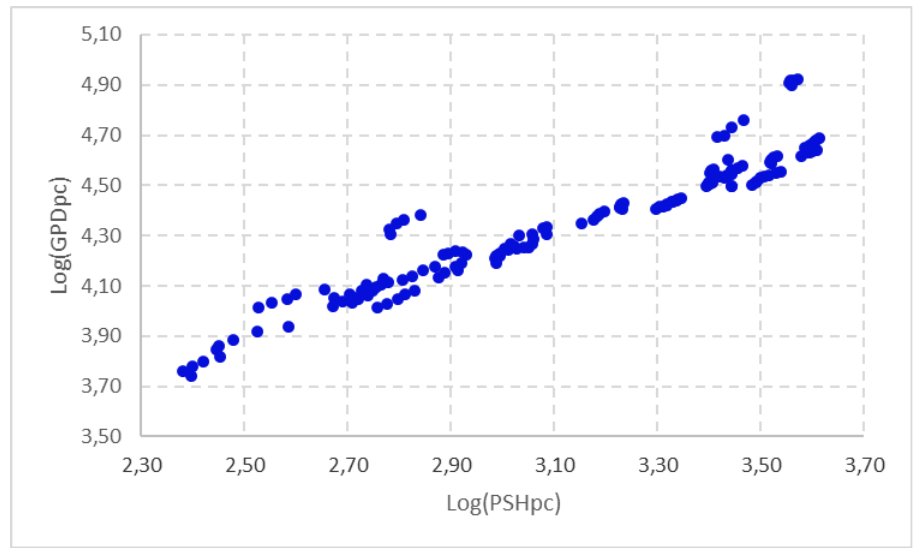
Figure 4. Relationship between PSH and the level of economic development of EU-28 countries (2014–2018). Source: Prepared by authors based on Eurostat.